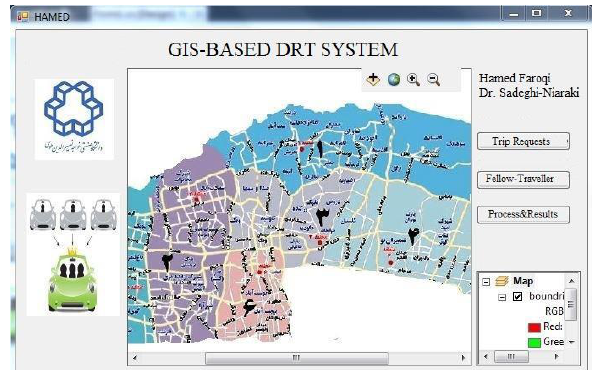
Figure 3. GIS-based DRT system application Therefore, 14 parking stations are located; besides 2000 trip requests based on above-mentioned explanation are simulated. for the simulated commuting data and map of Tehran city.